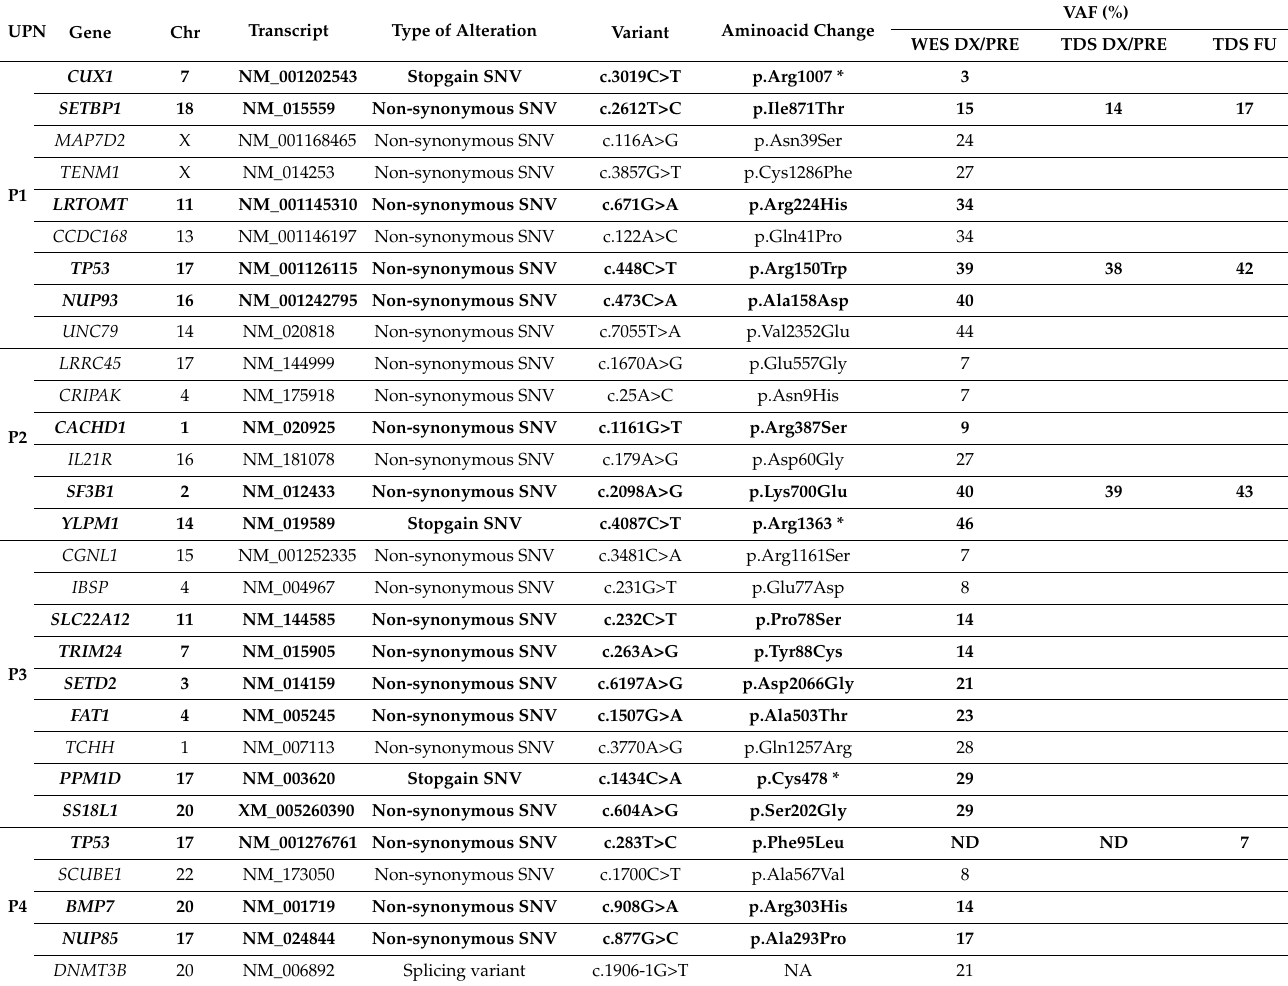
Table 2. Single nucleotide variants (SNVs) detected by whole exome sequencing (WES) and targeted deep sequencing (TDS) in diagnosis/pre-treatment samples and in the last available FU